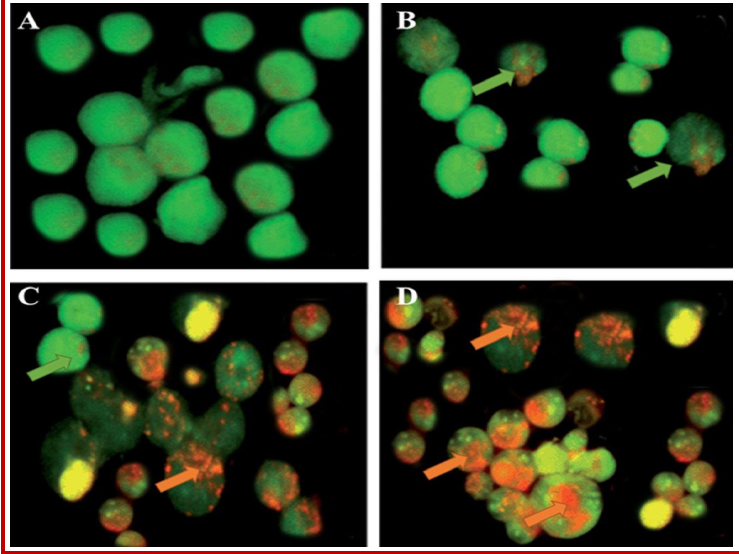
Figure 4: Fluorescence microscopy study of CaSki cervical cancer cells using acridine orange/propidium iodide (AO/PI) stain- ing. The cells were treated without (A, untreated control), and with 10, 50 and 100 µM of corosolic acid for 48 hours. Early and late apoptotic cells are shown by green and orange arrows